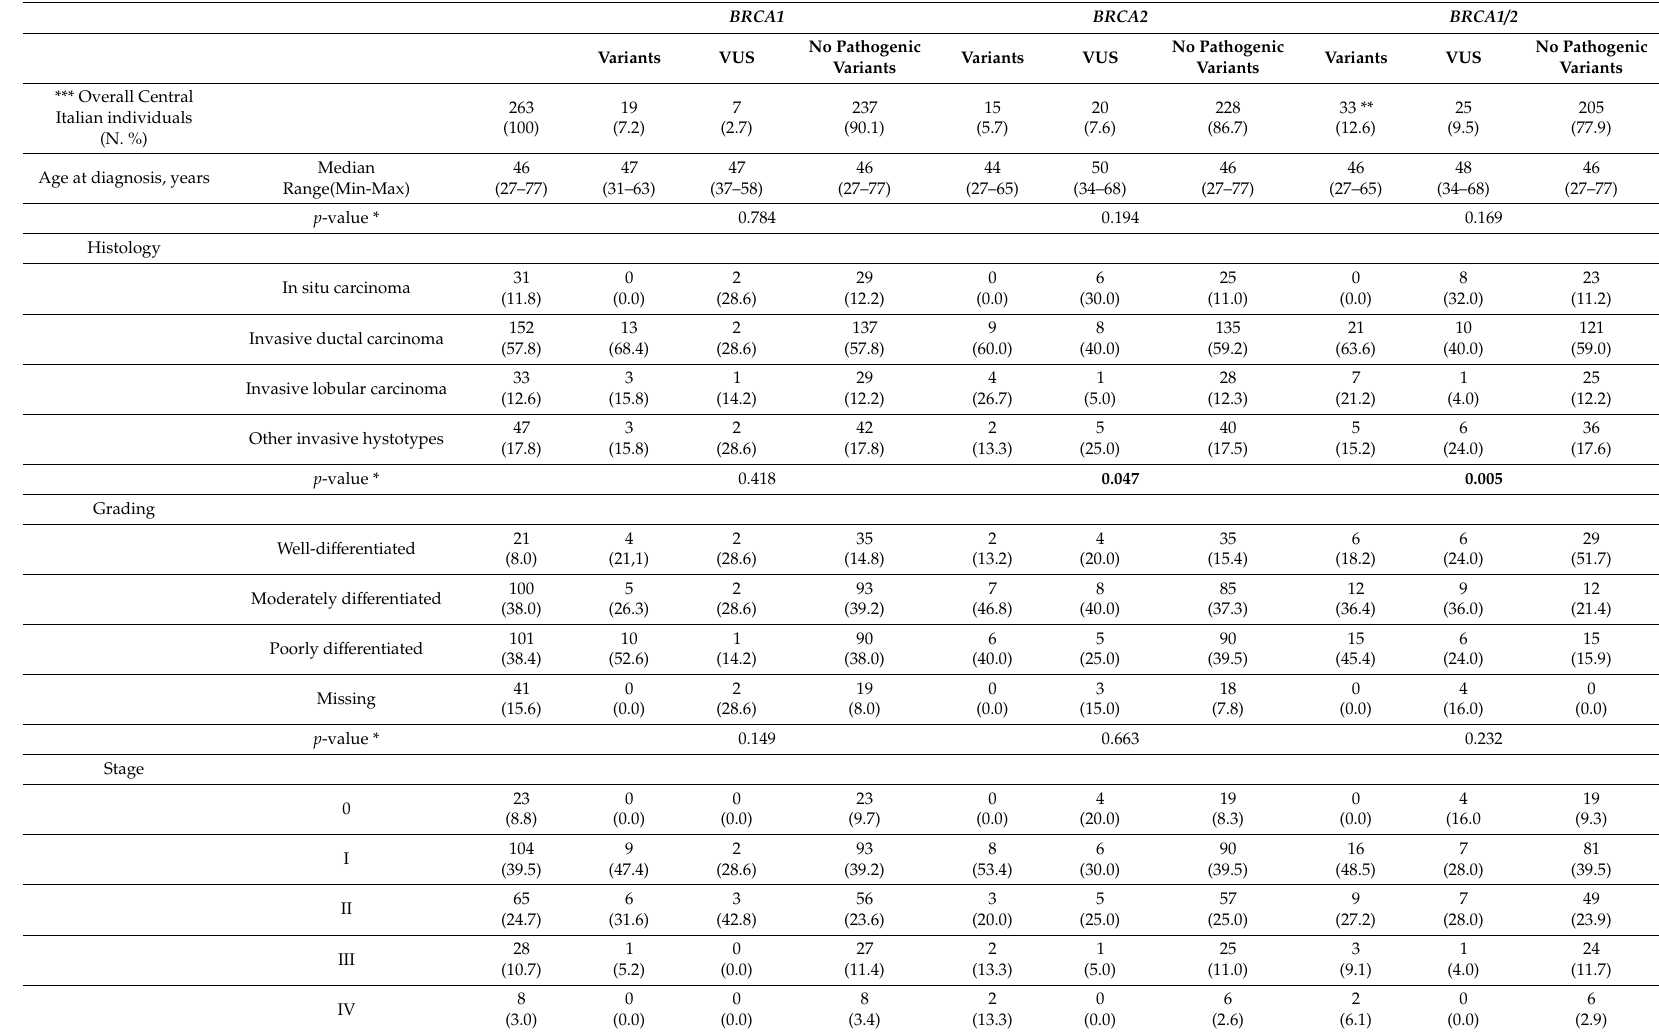
Table 3. Clinical features and BRCA status in